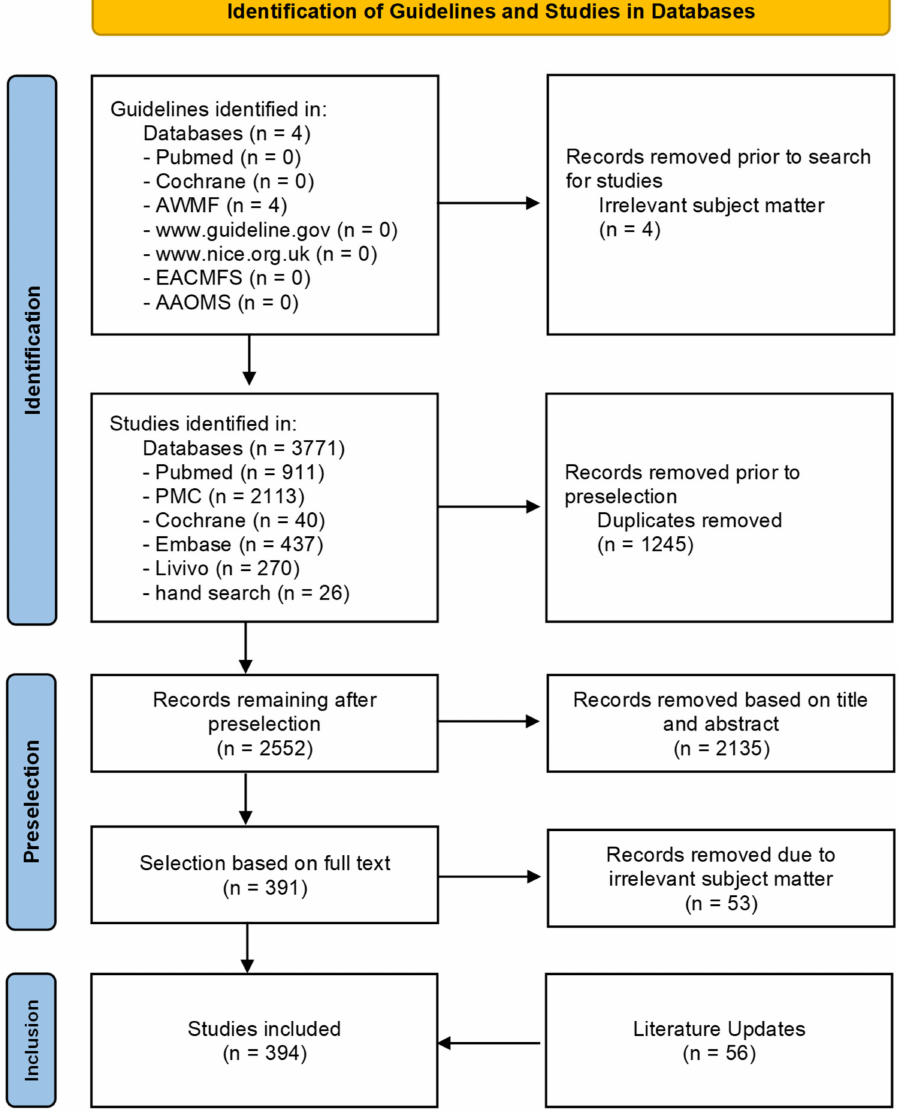
Figure 1. Literature search—PRISMA 2020 flow